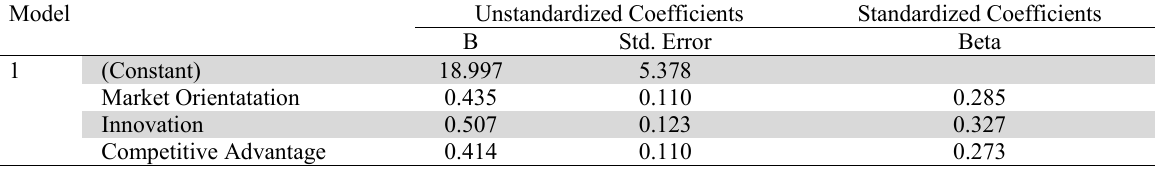
The results of Path Analysis for Equation 2 Model